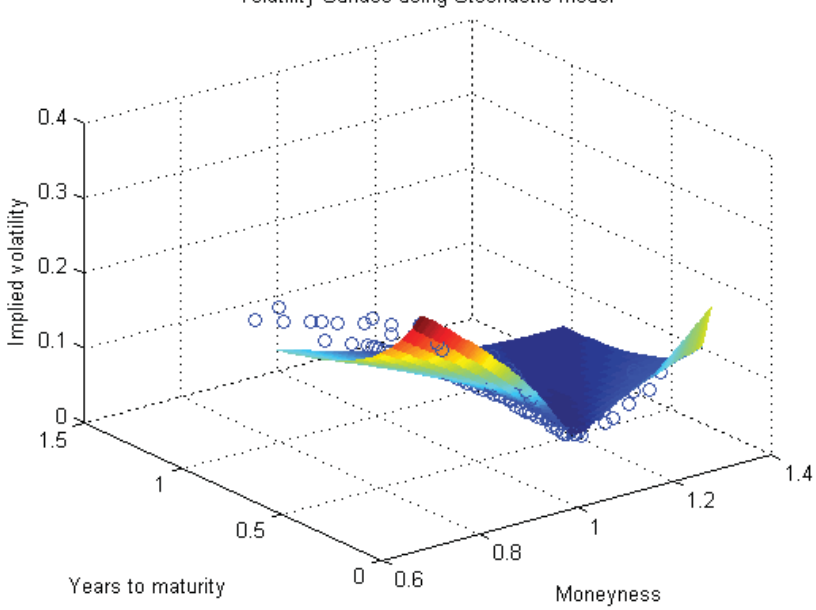
Fig. 4. Estimated implied volatility surface for Heston’s model. The blue circles are the observed volatilities